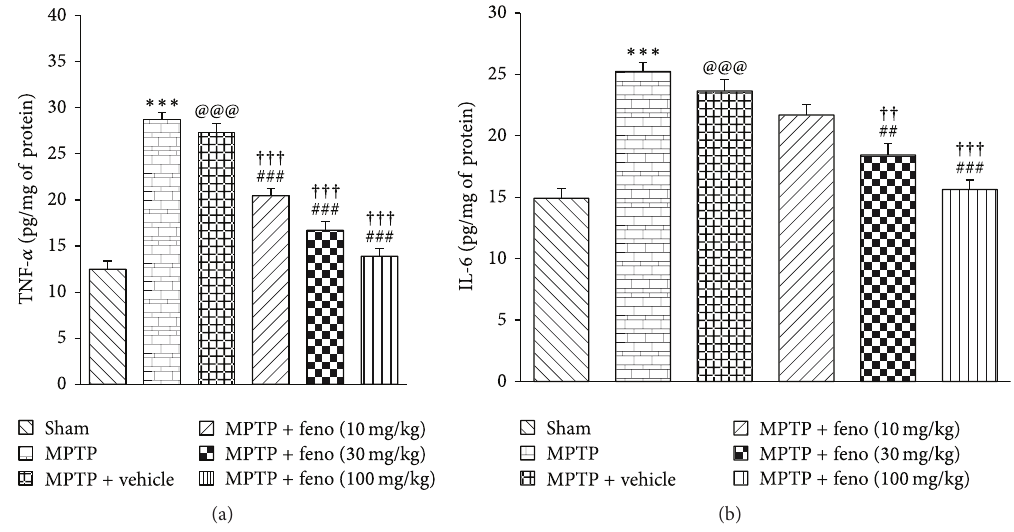
Figure 3: (a) Effect of fenofibrate on TNF- 𝛼 , (b) IL-6 level in different groups. ∗∗∗ 𝑃 < 0.001 MPTP versus sham, @@@ 𝑃 < 0.001 MPTP + vehicle versus sham; ## 𝑃 < 0.01 , ### 𝑃 < 0.001 MPTP versus feno 10, 30, and 100mg/kg treated groups; and †† 𝑃 < 0.01 , ††† 𝑃 < 0.001 MPTP + vehicle versus feno 10, 30, and 100mg/kg groups. All readings are expressed as mean ± SEM ( 𝑛 = 3 ).